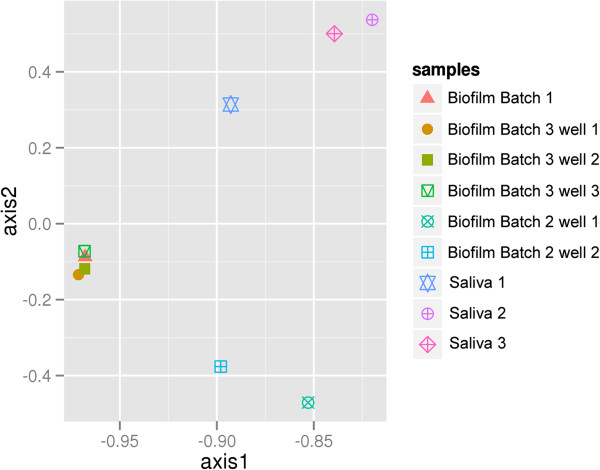
Correspondence analysis showing reproducibility and 16S profile similarities within biofilm and saliva samples. Axis 1 explains 47% of the variation in the dataset; axis 2 explains 19% of the variation. Replicate biofilm samples representing batches 1 and 3 cluster closely together whereas batch-2 biofilms that derive from an SIP experiment cluster more distantly along the first ordination axis. Saliva-derived replicates (1 to 3) also show similar 16S diversity.